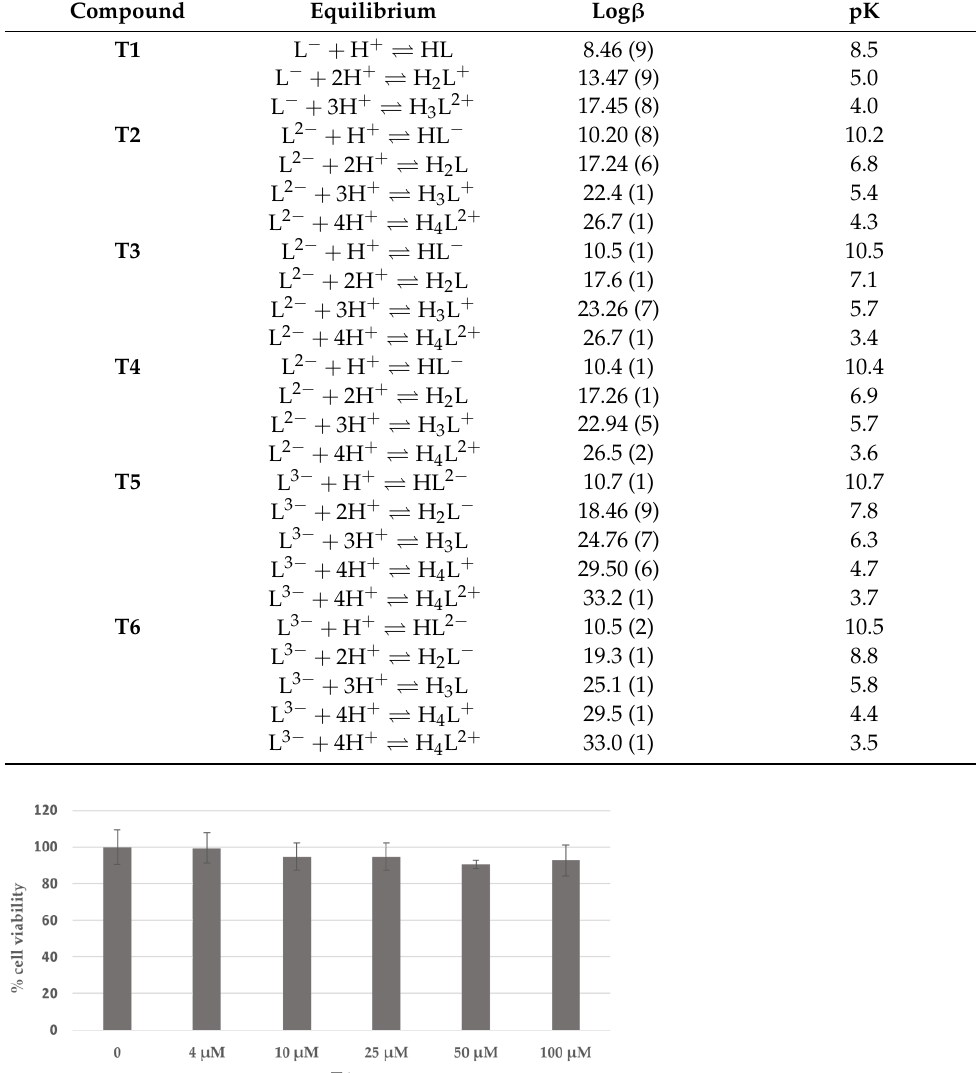
Table 4. Protonation constants of T1–6 (25 ◦ C, NaCl 0.1 M). The standard deviation to the last significant figure is reported in parentheses.